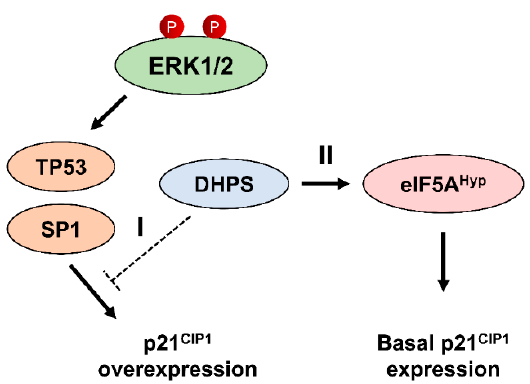
Figure 7. A proposed role for DHPS in p21 CIP1 regulation in cells. (I) DHPS suppresses p21 CIP1 overexpression, which can be induced by aberrant ERK1/2 activity and mediated by TP53 and SP1 in certain tumor cells. This DHPS function is independent of its ability to hypusinate eIF5A. (II) DHPS can also regulate basal p21 CIP1 levels in cells through eIF5A hypusination. These mechnanisms may be involved in p21 CIP1 -mediated regulation of cell proliferation and survival.